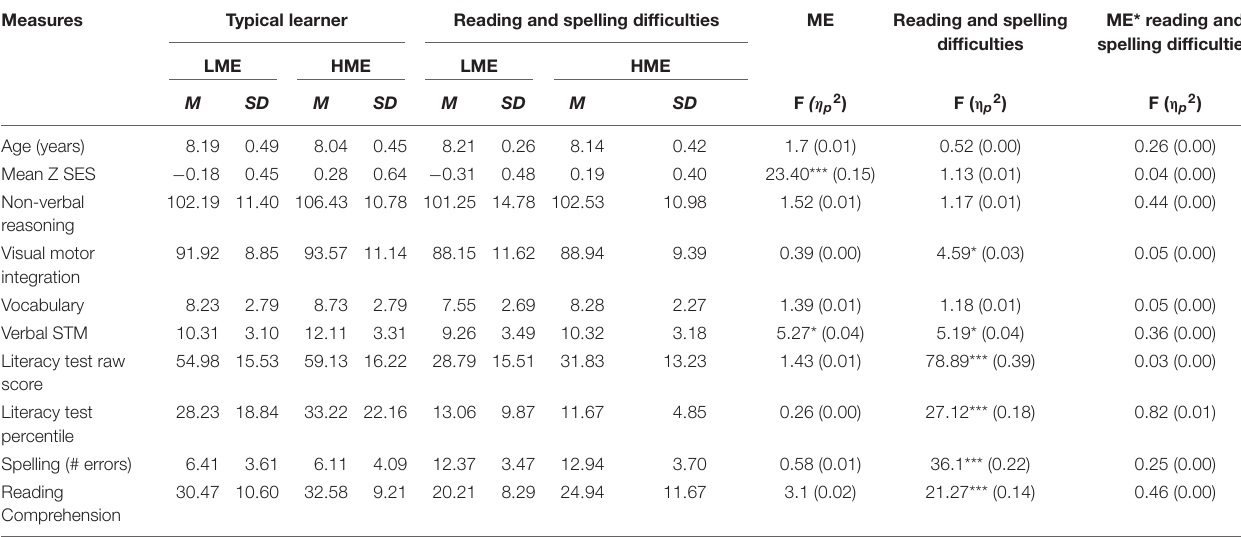
TABLE 1 | Means, standard deviations, and analysis of variance (ANOVA) of descriptive